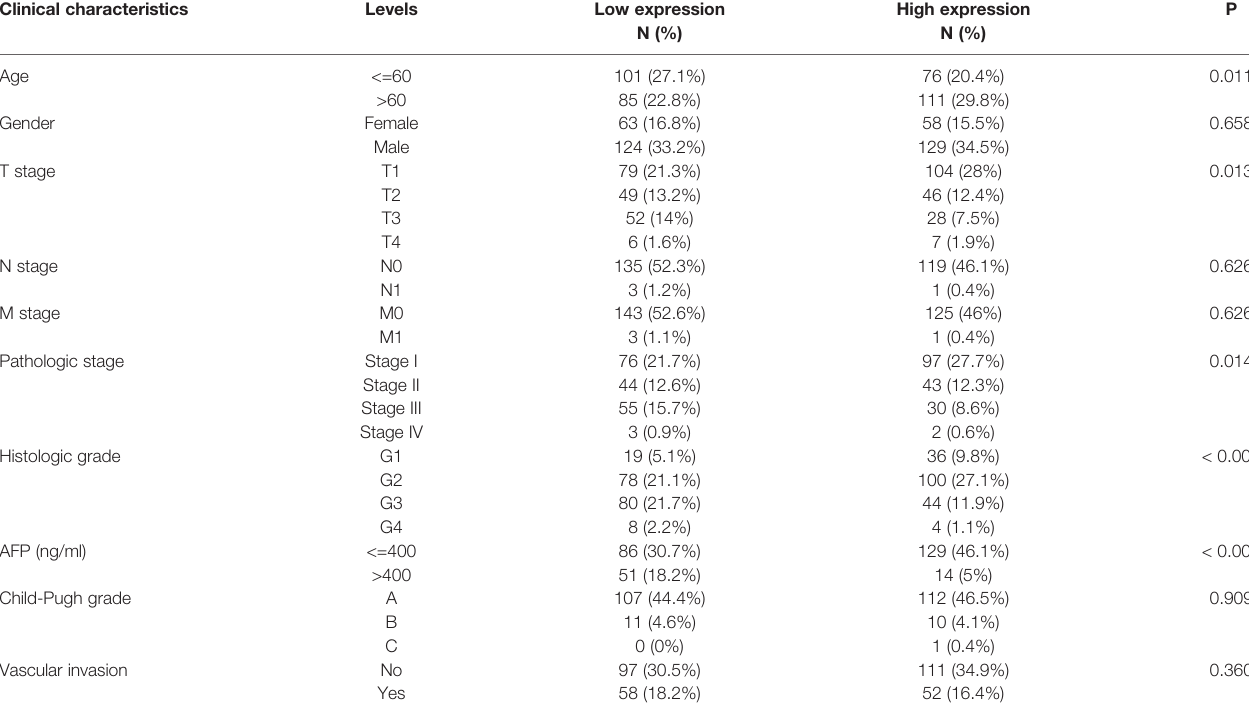
TABLE 1 | Relationship between ABAT expression and clinical characteristics. Clinical characteristics